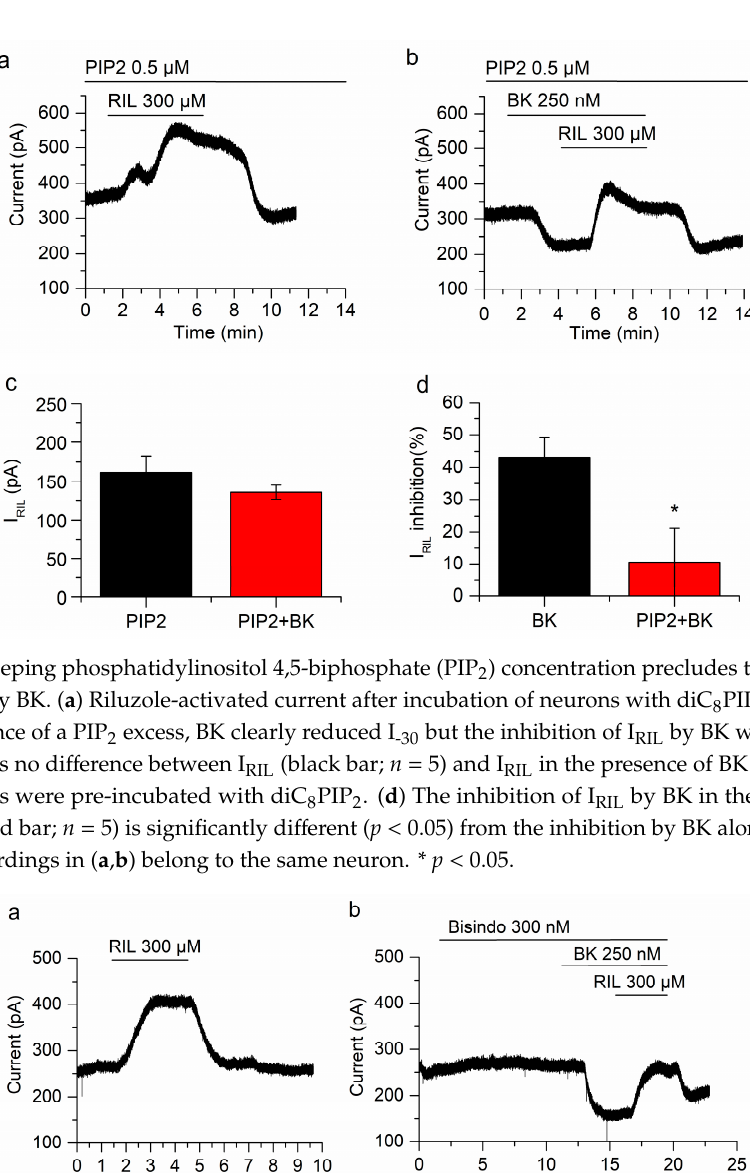
comparing riluzole activation in the presence and absence of 2-APB and differences were not found [26]. Interestingly, the application of 2-APB produced a fast increase of I -30 (71.4 ± 19.3 pA; p = 0.020; Figure 7b), this was a transient effect that slowly decreased in − 29.9 ± 9.7 pA ( p = 0.037). This was in agreement with 2-APB acting as a TREK-2 activator [51]. The application of BK (250 nM) still reduced I -30 in the presence of 2-APB ( − 48.3 ± 1.5 pA; p = 5.18 × 10 − 6 ; n = 5; Figure 7b), probably reflecting the inhibition of the TREK-2 current, previously activated by 2-APB.